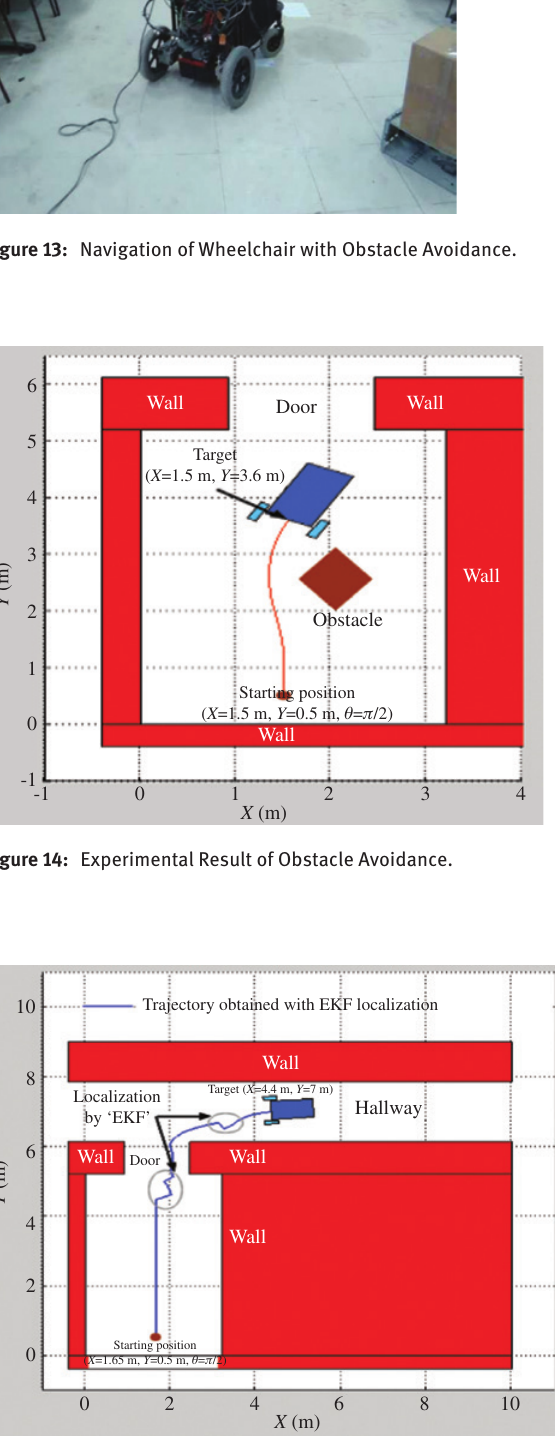
Figure 15: Experimental Results of the Navigation, Obstacle Avoidance, and